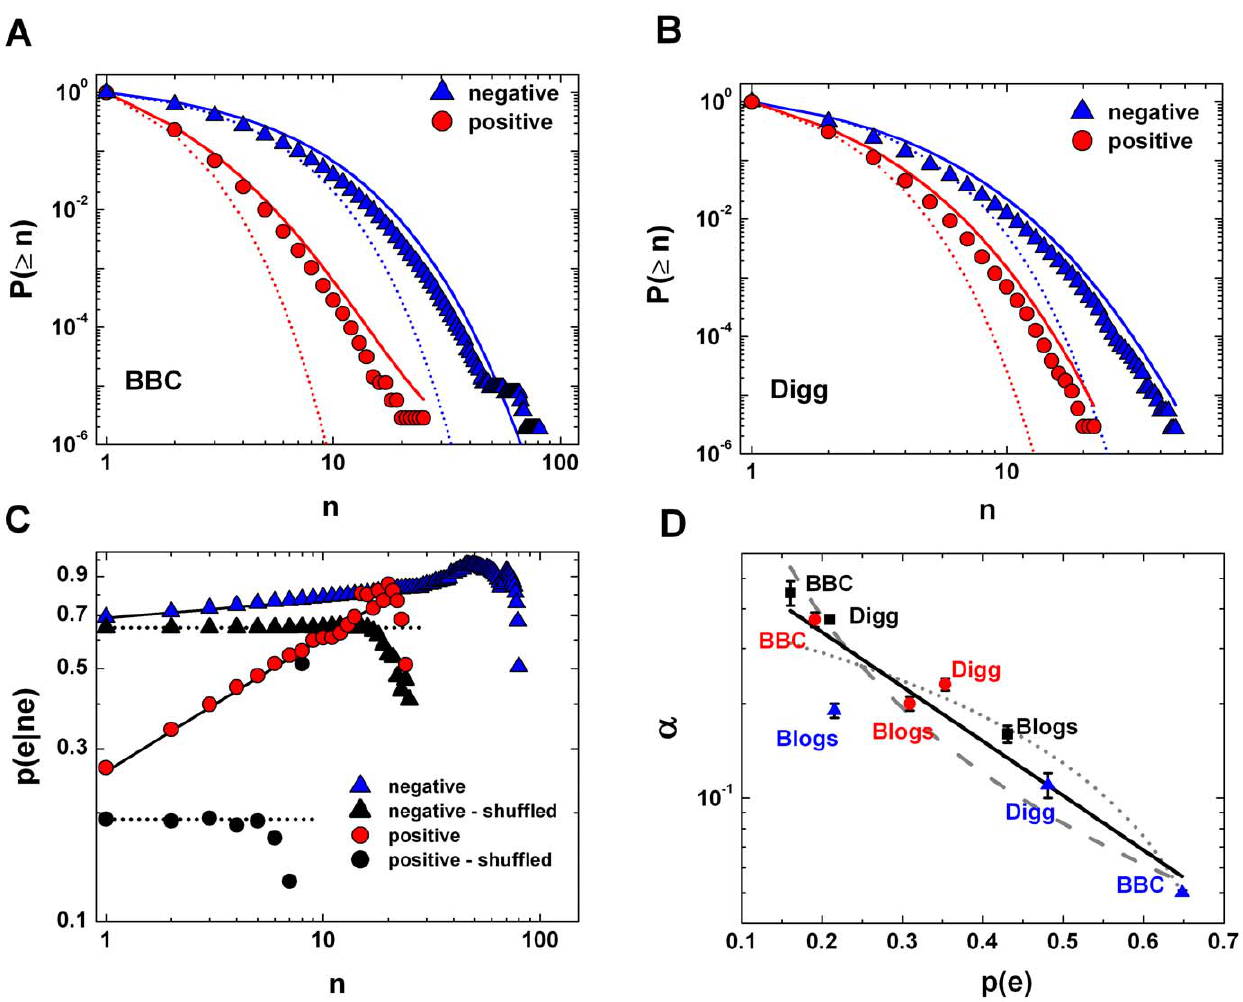
Figure 3. Emotional clustering in Digg, BBC and Blog data. (A–B) Cumulative cluster distributions for the BBC (A) and Digg data (B). Points correspond to the collected data (circles - positive messages, triangles - negative messages). Dotted lines are the i.i.d. process, and solid lines derive from Eq (3). It is clear that messages are mutually dependent and using the model with preferential cluster growth leads to a better fit with collected data. (C) The conditional probability of the next comment occurring having the same emotion for BBC (open symbols) data. Circles come from positive messages and triangles from negative messages. We observe that p ( e j ne ) ~ p ( e j e ) n a (solid lines) in the first ten where there is the best statistics available (the largest number of comments) of the gathered data. Filled symbols indicate the shuffled data and dotted lines show the values of emotional probabilities p ( z ) and p ( { ) for BBC data (see Table 1). Note that p i : i : d : ( e j ne ) ~ p ( e ) fits well to shuffled data for small values of n . (D) The preferential exponent a decays with emotion frequency p ( e ) although no exact relation can be received from the collected data. The solid line follows the relation a ~ B exp ½ { b p ( e ) (cid:2) with B ~ 0 : 75 + 0 : 14 and b ~ 4 : 0 + 0 : 5 while dotted and dashed curves are, respectively, power-law and linear fits. The value of R 2 for exponential fit is 0.96, while for power-law and linear it is 0.94 and 0.90